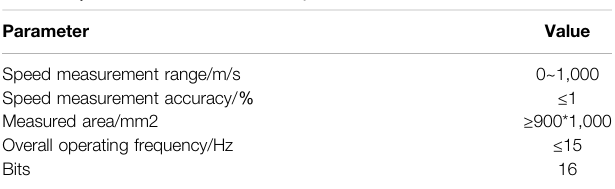
TABLE 4 | Technical index of PIV test